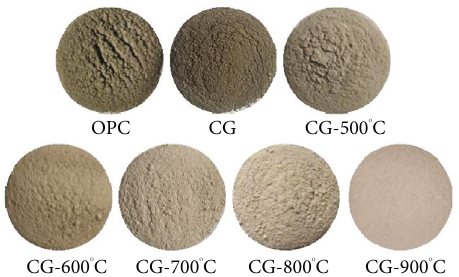
Figure 2: Apparent characteristics of OPC and CG at calcination temperatures of 500 ° C-800 °